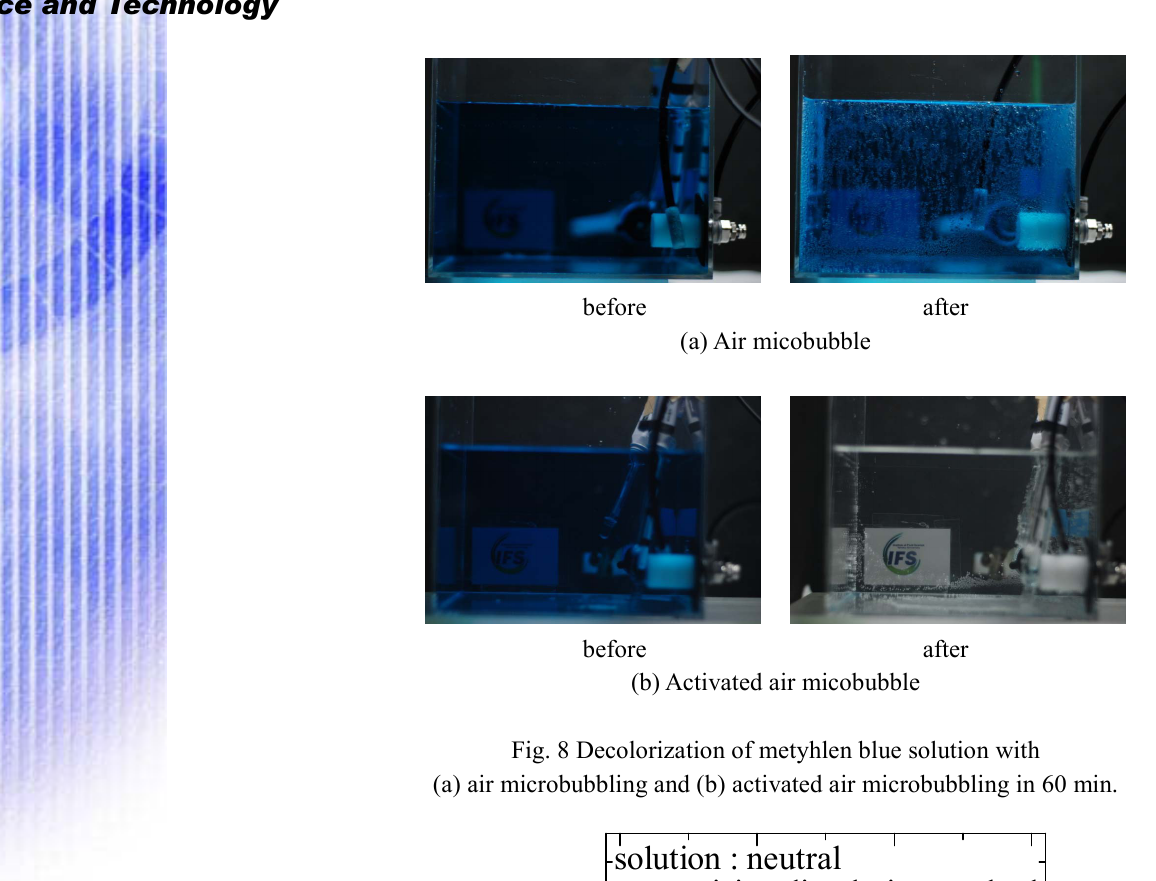
Fig. 8 Decolorization of metyhlen blue solution with